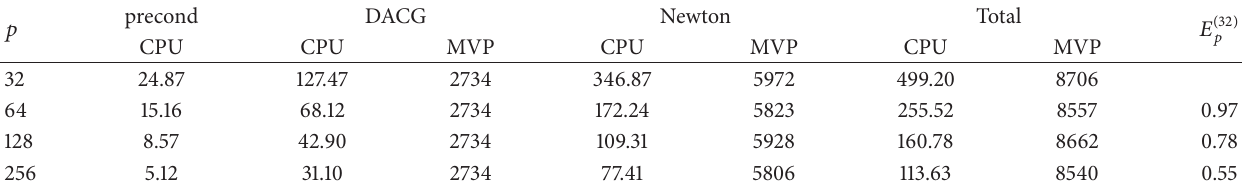
Table 8: Iterations, timings, and pseudo efficiencies for problem LONG-1103 .